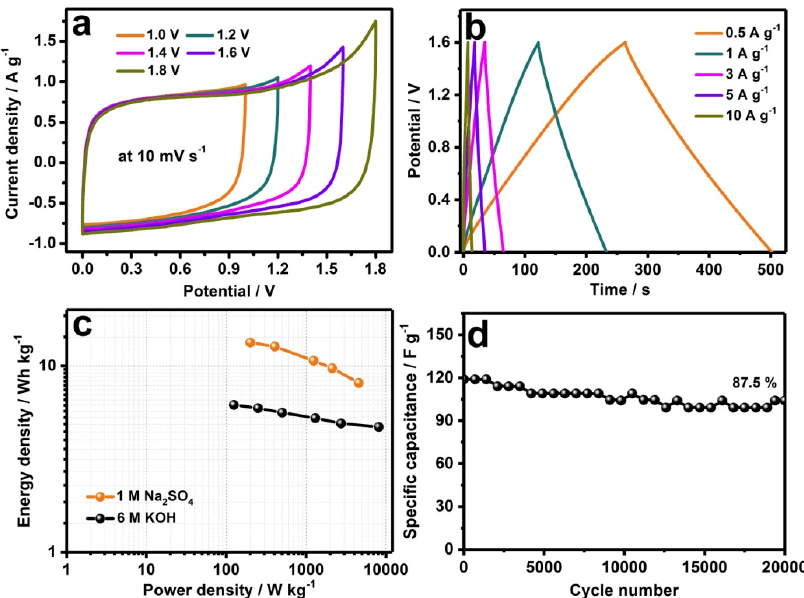
Figure 9. Electrocapacitive features for SSC of NHCSF-3//NHCSF-3 operating in 1 M Na 2 SO 4 electrolyte. ( a ) CVs at 10 mV s − 1 under different conditions of potential window; ( b ) GCD curves at different current loads; ( c ) Ragone plots; ( d ) cyclic performance at 4 A g − 1 up to 20,000 cycles [135].